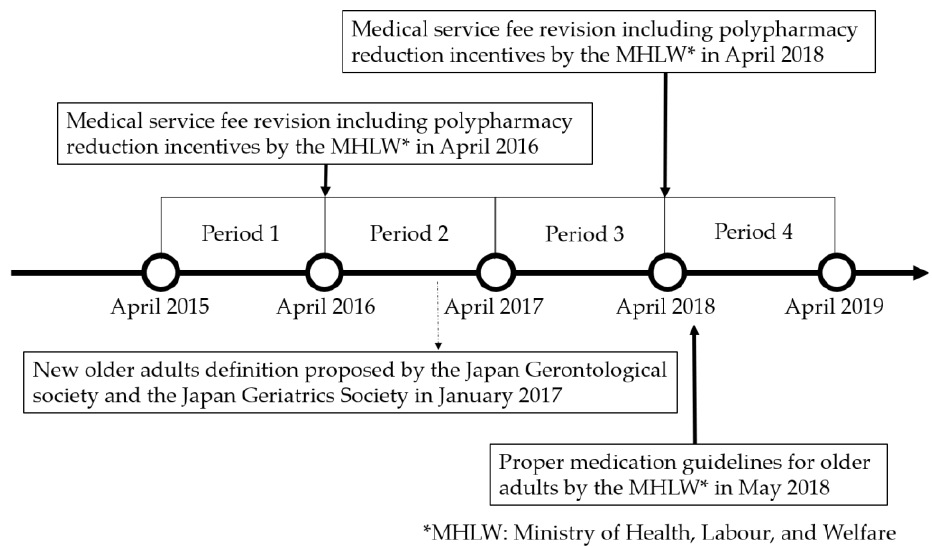
Figure 1. Research period timeline with relevant guidelines and